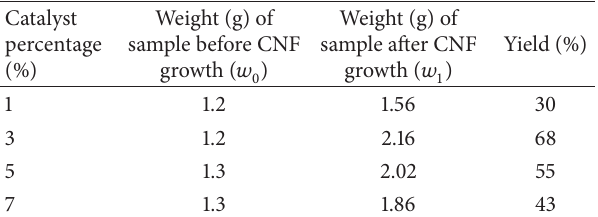
Table 1: Yield percentage of the CNF growth on impregnated